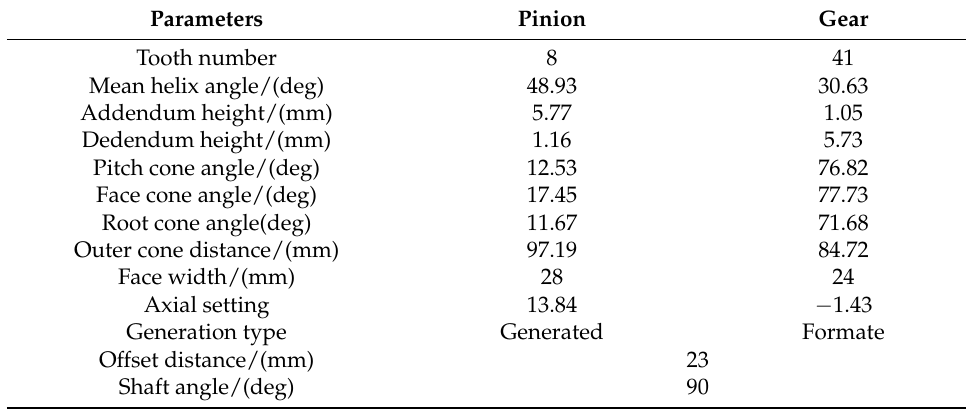
Table 2. Machining parameters for theoretical tooth surfaces.